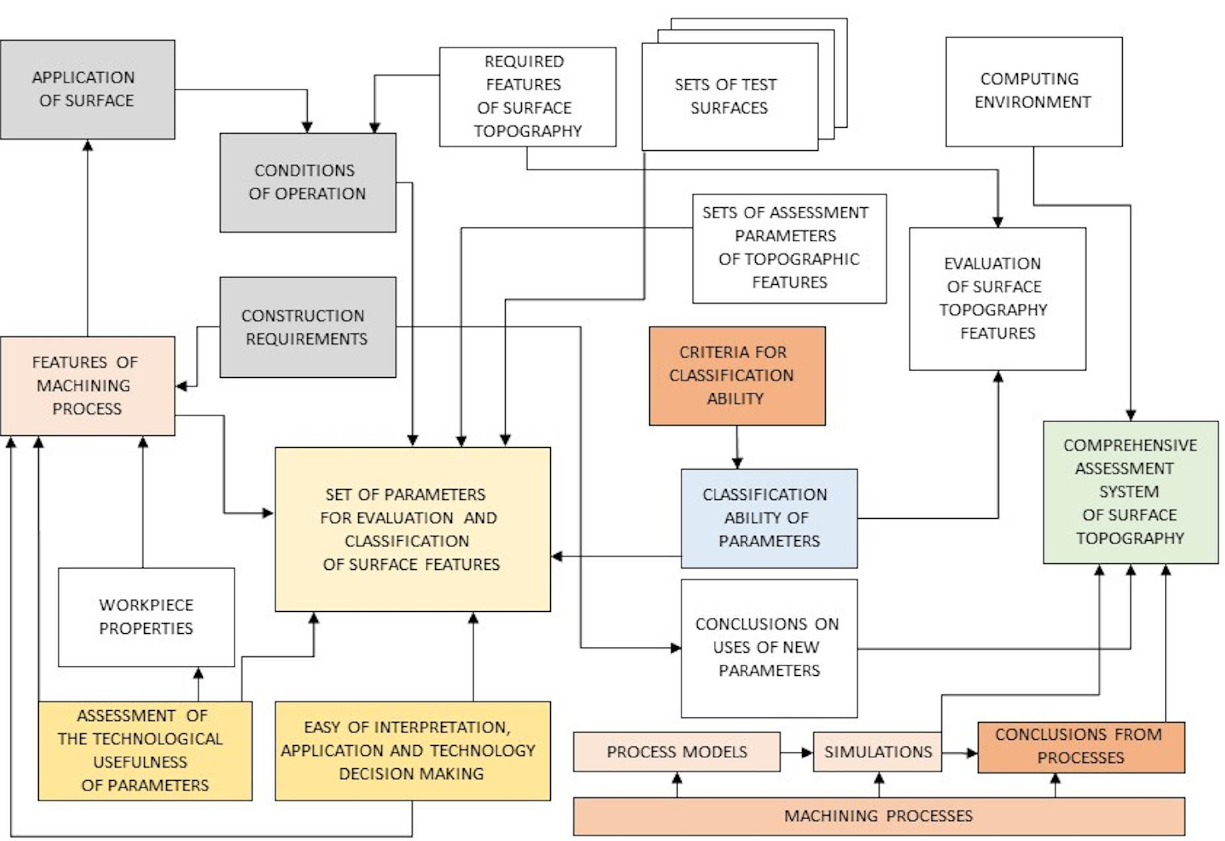
Figure 8. A scheme of the system of comprehensive evaluation of geometric characteristics of surfaces in terms of decisions in the process of design and manufacture of technical components .